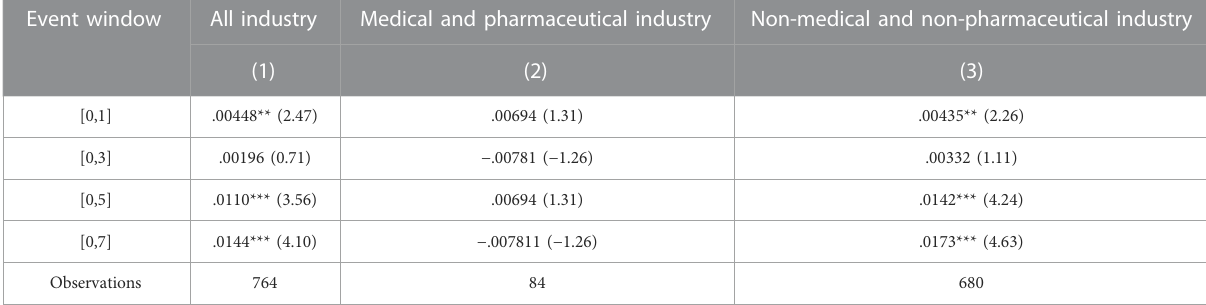
TABLE 5 The GEM ’ s respond to “ RRR Reduction ”